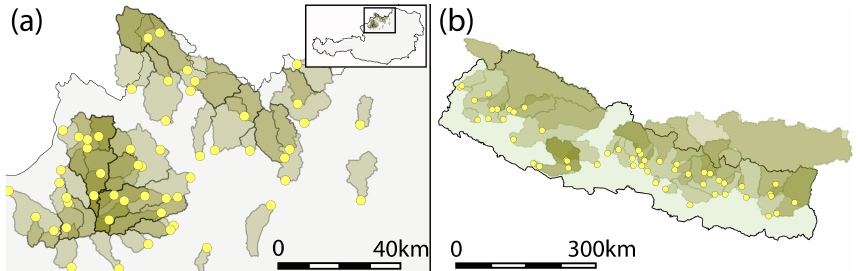
Figure 3. Location of the gauges and related catchments included in the cross-validation analyses in Upper Austria (a) and Nepal (b) . Col- oring is semi-transparent to emphasize overlapping catchment areas. Dark colors represent upstream catchments, whose runoff is monitored by many gauges downstream. Light colors represent downstream catchments with only few downstream gauges to monitor